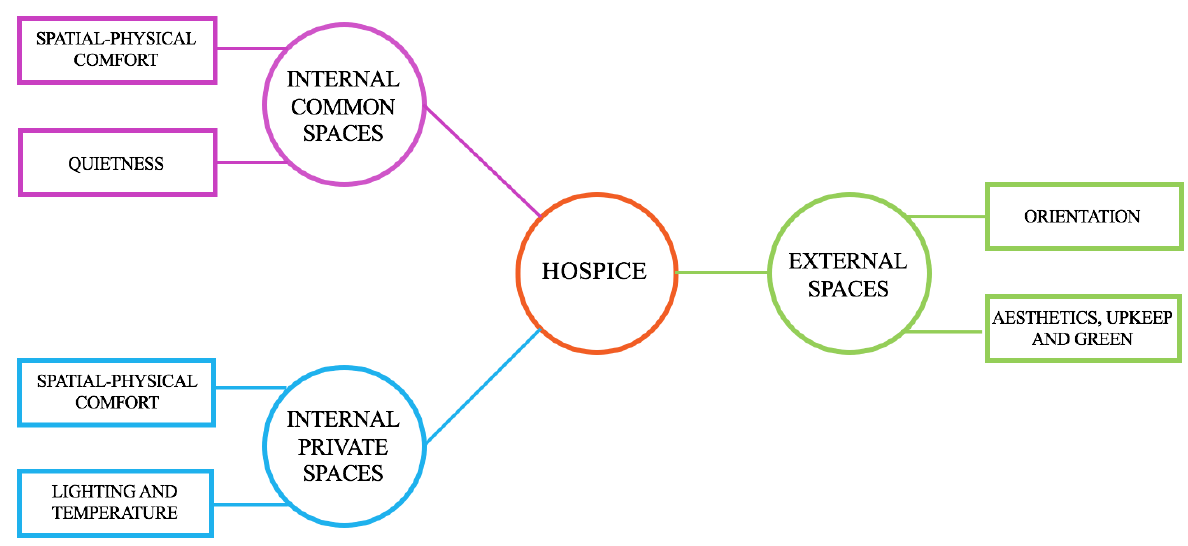
Figure 1. Hospice PHEQIs (Perceived Hospital Environment Quality Indicators). Specifically, the following outcomes were expected.